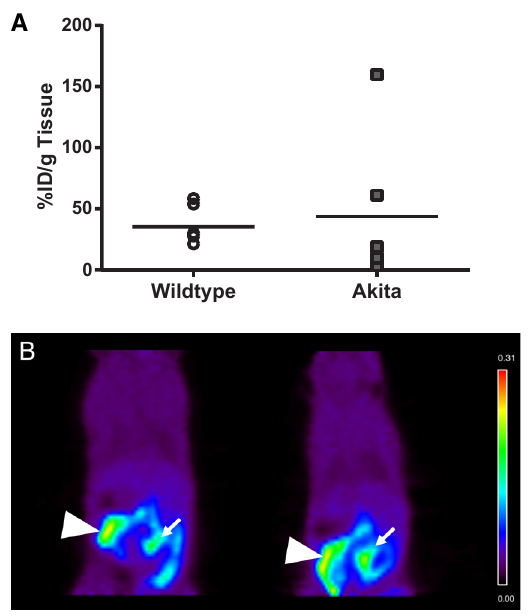
Figure 2. Pancreas-specific uptake of 18 F-L-FEHTP in wt and Akita mice. a ) Ex vivo tracer uptake was calculated for the pancreas of wt (n=6) and Akita (n=6) mice as % ID/g tissue at 1.5 h after injection. b ) PET imaging of the pancreas after injection of 18 F-L- FEHTP. One hour after injection, static images were acquired for 30 min. Representative images of wt (n=6) and Akita (n=5) mice show highly specific uptake in the pancreas with little detectable background uptake. Arrowheads indicate position of the pancreas. Arrows indicate position of